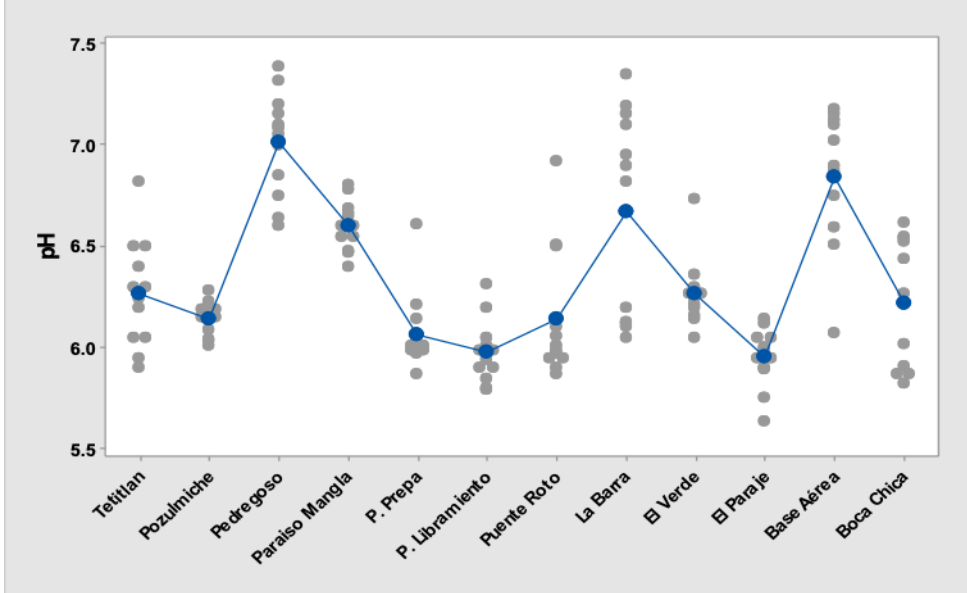
Figure 3. pH values in each location; the grey points refer to the data dispersion in relation to the mean represented by the blue